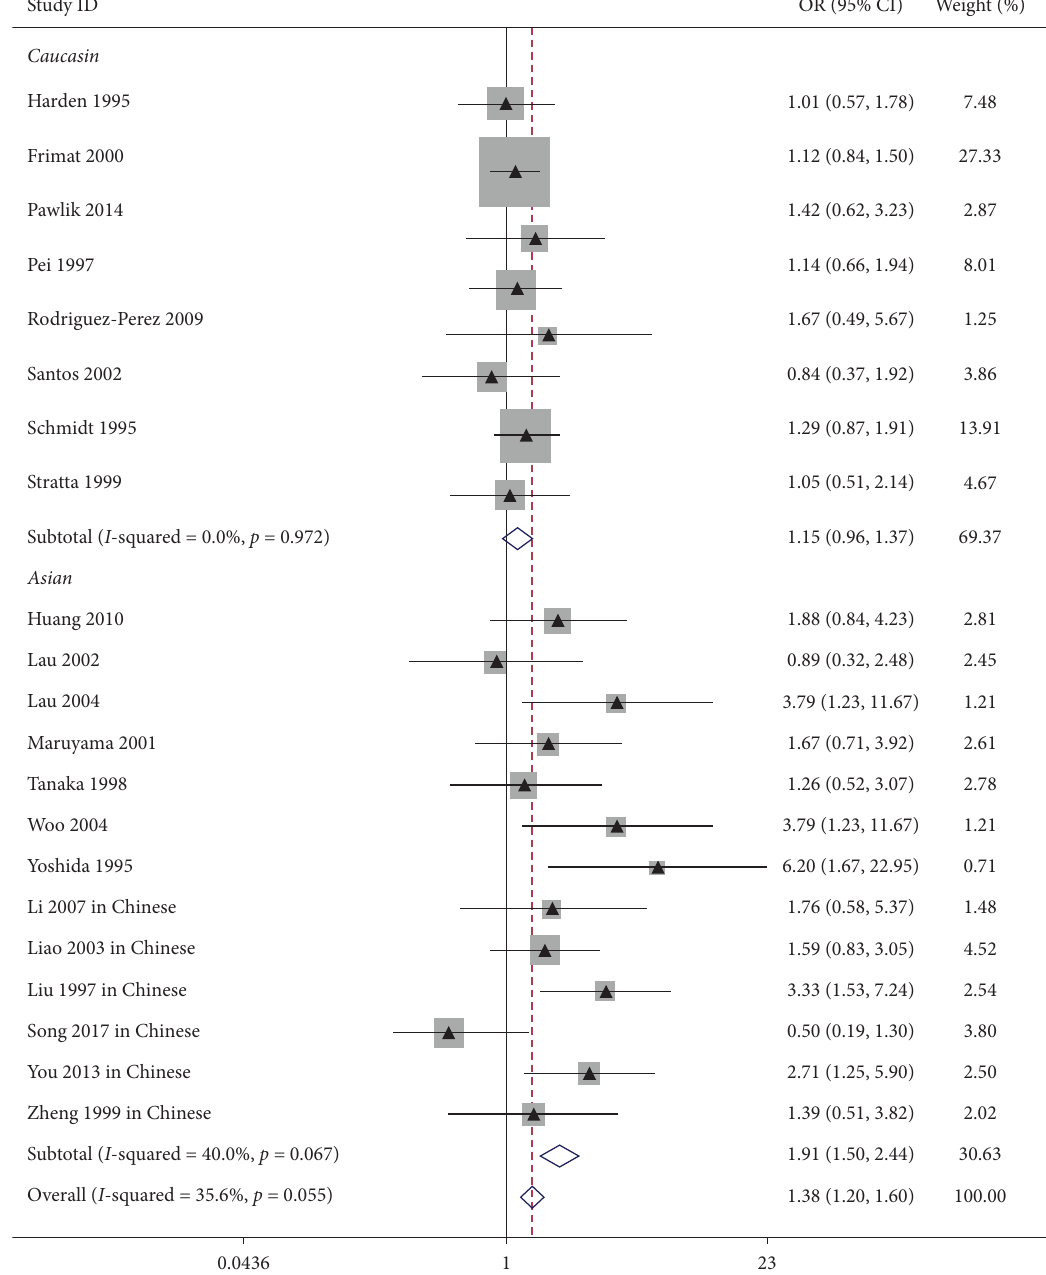
Figure 2: Forest plot about the link between ACE I/ D gene polymorphism and IgAN risk (genotype DD vs. genotype ID+II). It showed that the ACE gene locus DD genotype was a risk factor of IgAN in the overall and Asian